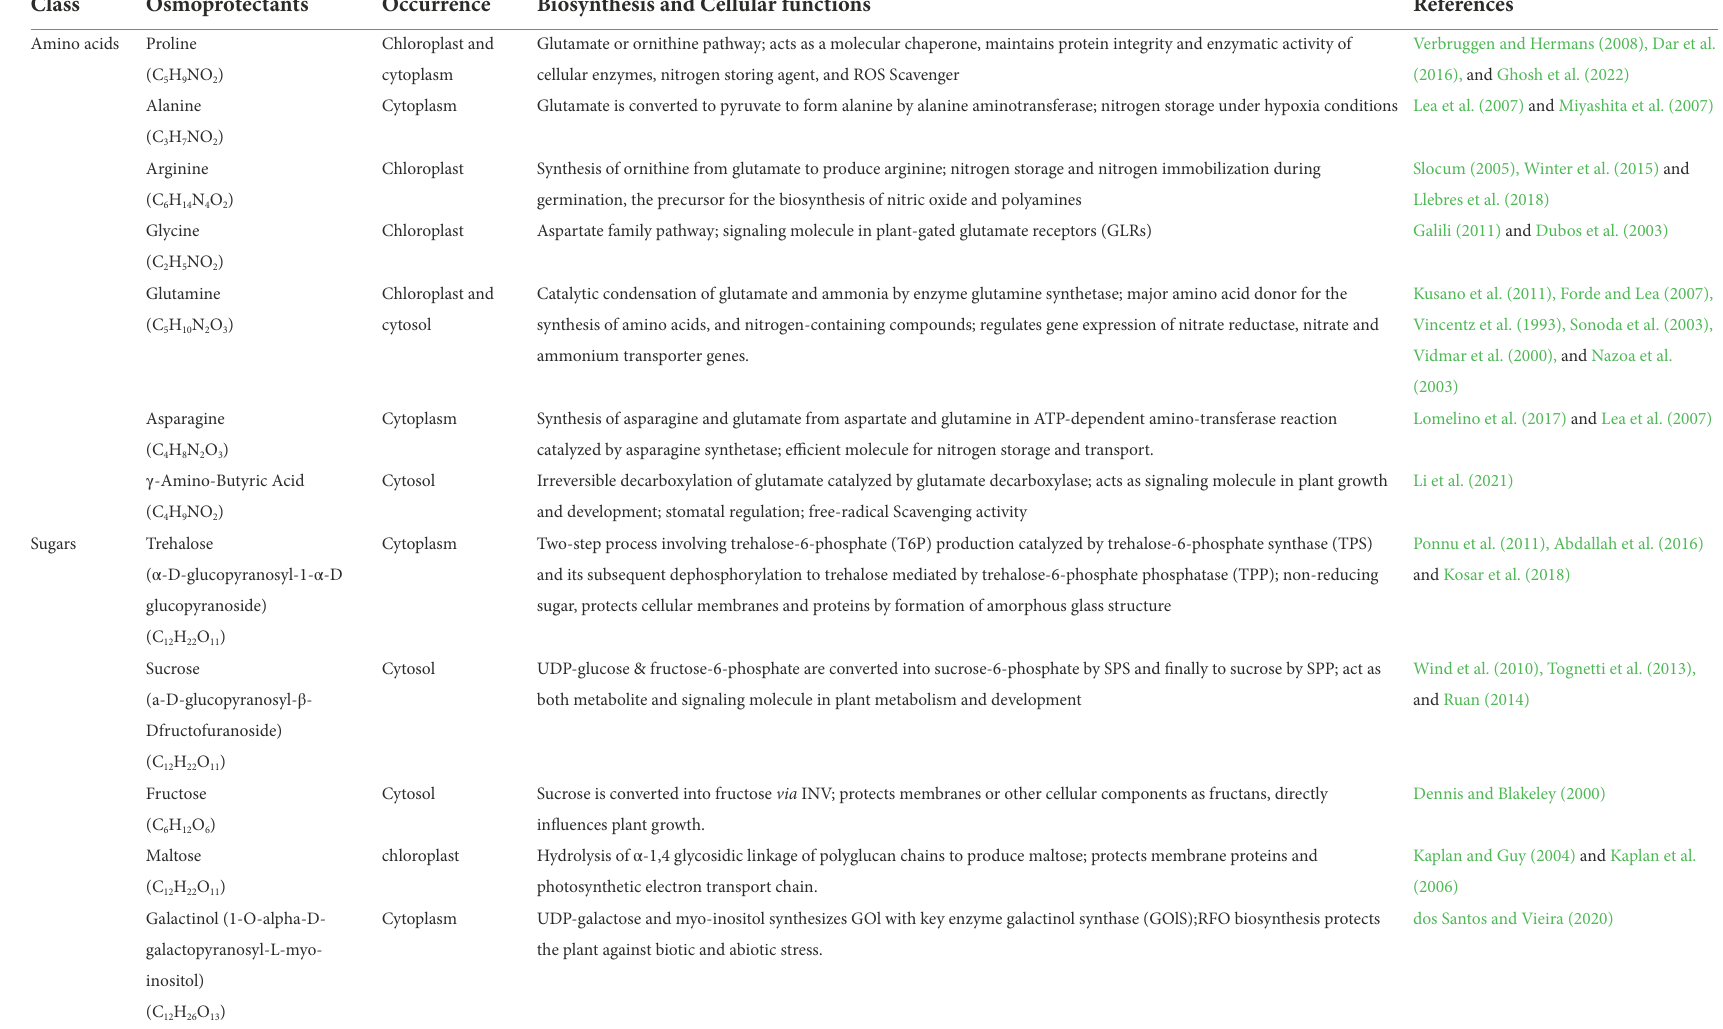
TABLE 1 Biosynthetic pathways of osmoprotectants and their cellular